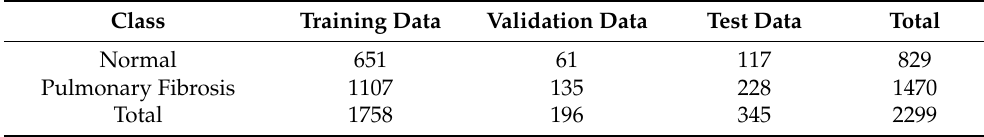
Figure 4. ( a , b ). Data samples from the combined chest CT scan image dataset ( a ) show Pulmonary Fibrosis chest CT image slices, and ( b ) show normal chest CT image slices. Table 2. Details of the distribution of chest CT images in each class and across the training, validation, and testing